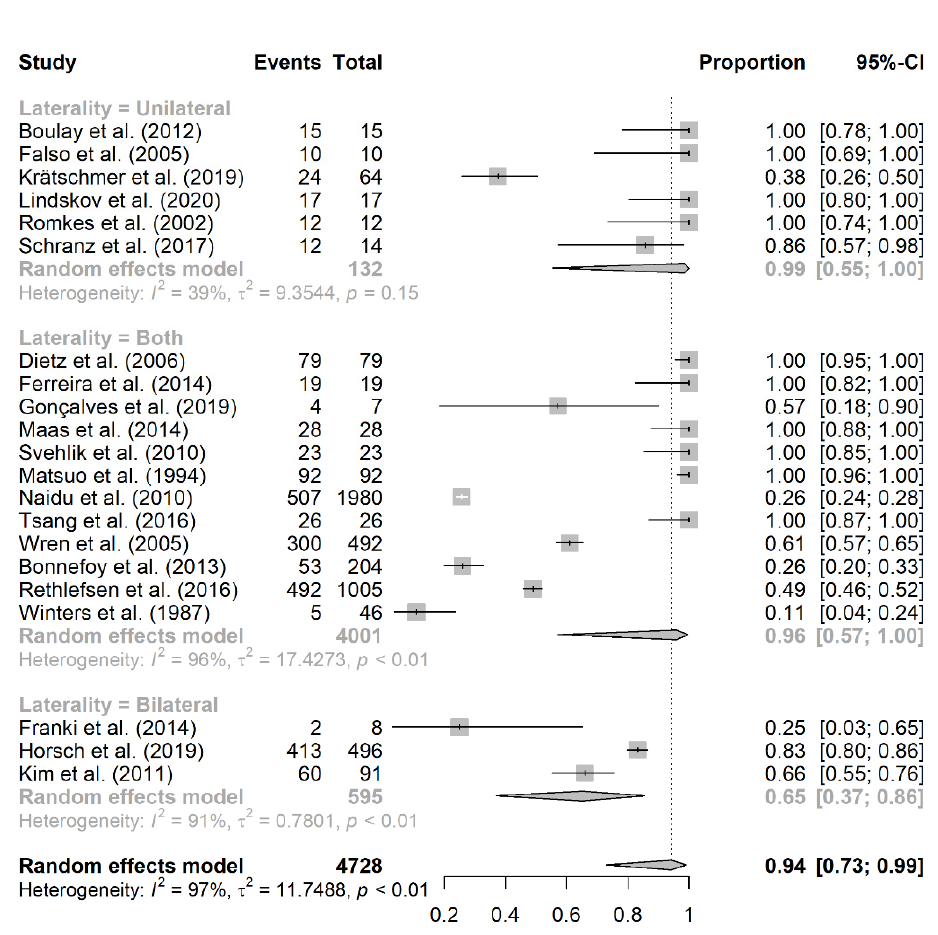
Figure 3. Subgroup analysis of equinus foot prevalence based on the laterality of cerebral palsy.